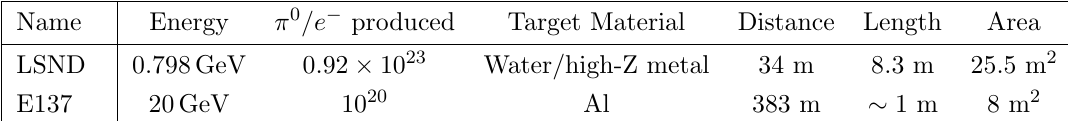
Table 3. Characteristics of the experiments considered. We de(cid:12)ne the detector distances from the beam target to the center of the detector. LSND has a cylindrical geometry while E137 has a square intersection with the beam axis. The e(cid:11)ective detector distance considered for E137 is developed in the